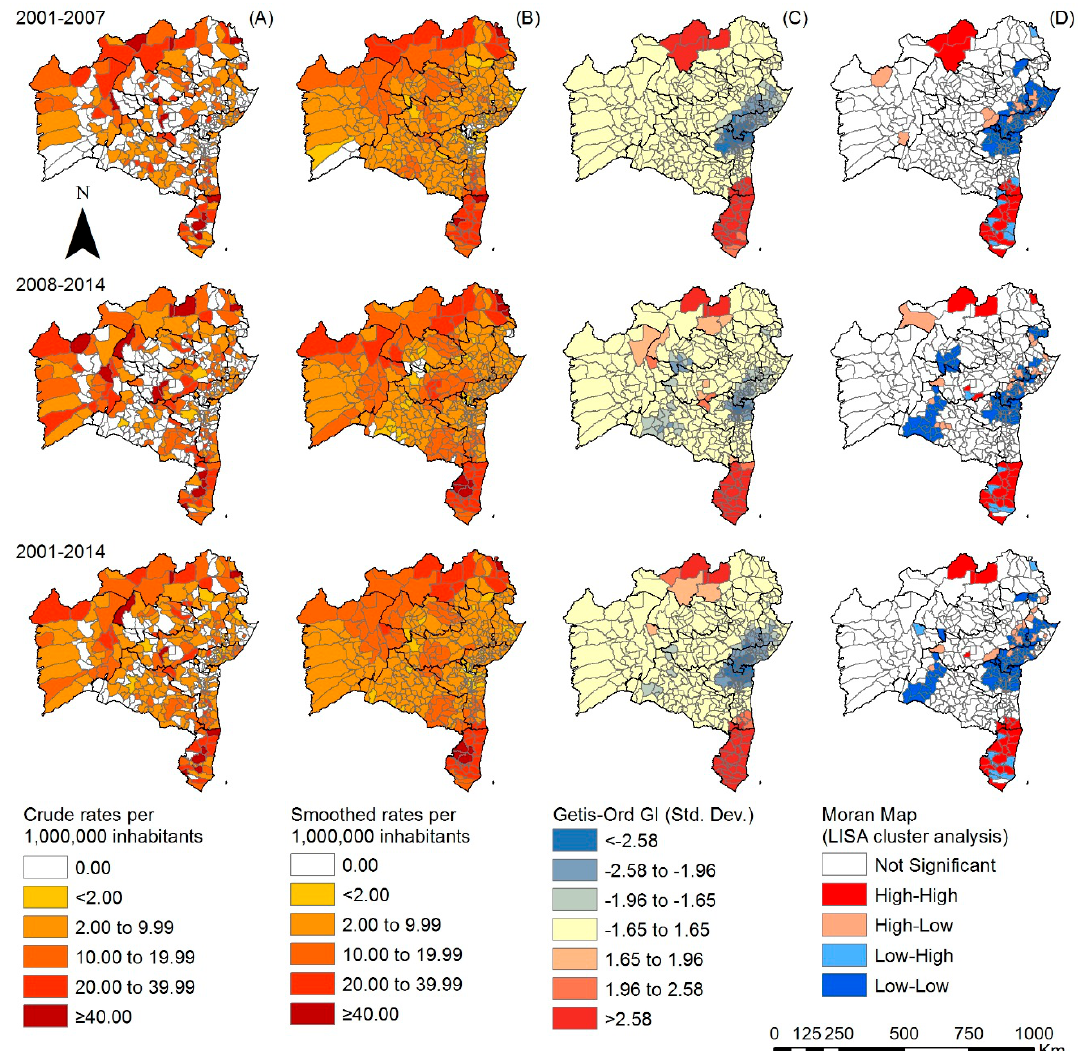
Figure 4. Spatiotemporal distribution of G2D per million people by municipality, Bahia state, 2001–2014: ( A ) crude detection rate of new cases of leprosy (per 1,000,000 inhabitants); ( B ) Bayesian-smoothed detection rate (per 1,000,000 inhabitants); ( C ) hot-spot analysis (Getis-Ord Gi*) and ( D ) LISA cluster analysis (Moran Map).